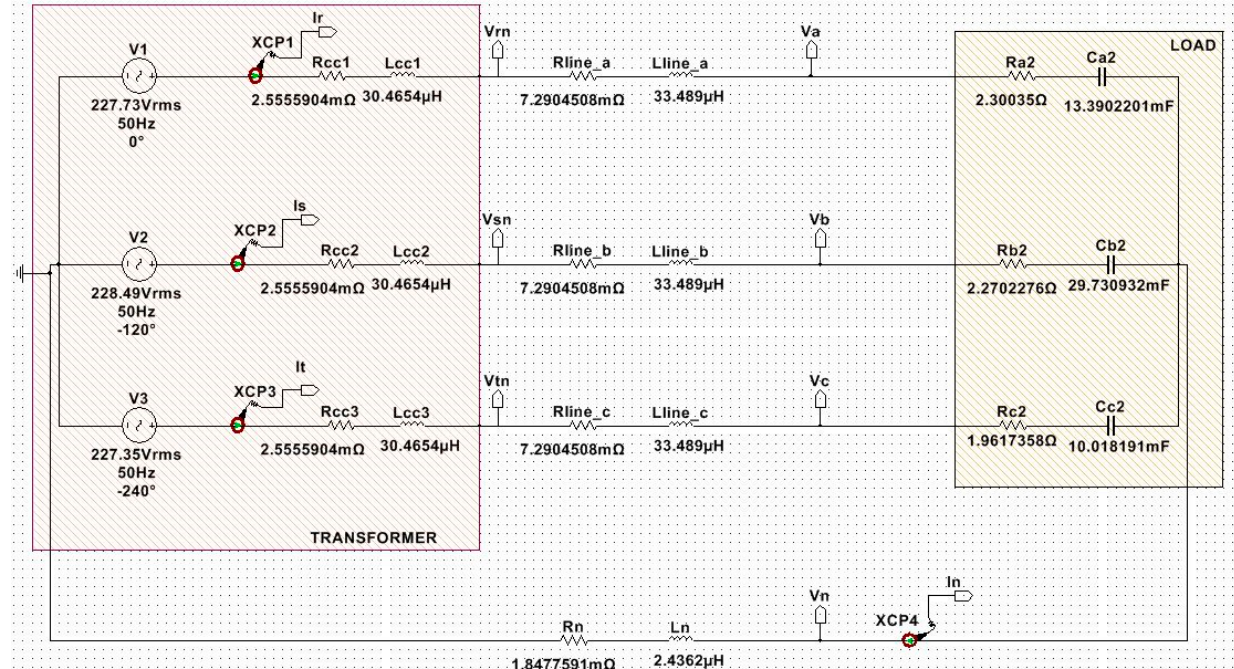
Figure 8. Scheme of the actual residential distribution network used in the application example and placement of the Fluke 435 Series II analyzer.